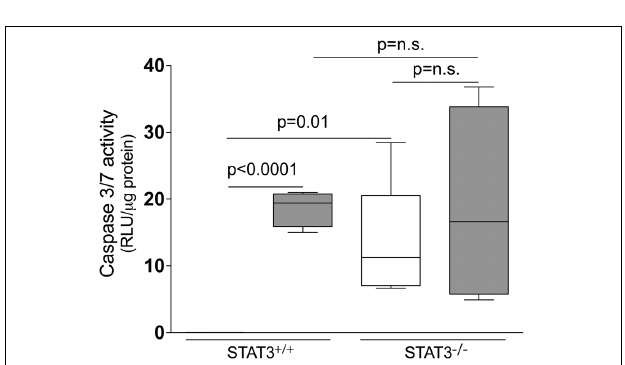
FIGURE 7 | STAT3 activity enhances lung SOCS-3 levels. Lungs from STAT3 + / + and STAT3 − / − mice exposed to room air or smoke for 8 days were homogenized and SOCS3 and actin were detected by immunoblot. Densitometry analysis was performed and results are represented as SOCS3 protein relative to air-exposed STAT3 + / + mice. Actin levels were also used to normalize protein loading and are reflected in graph shown here.